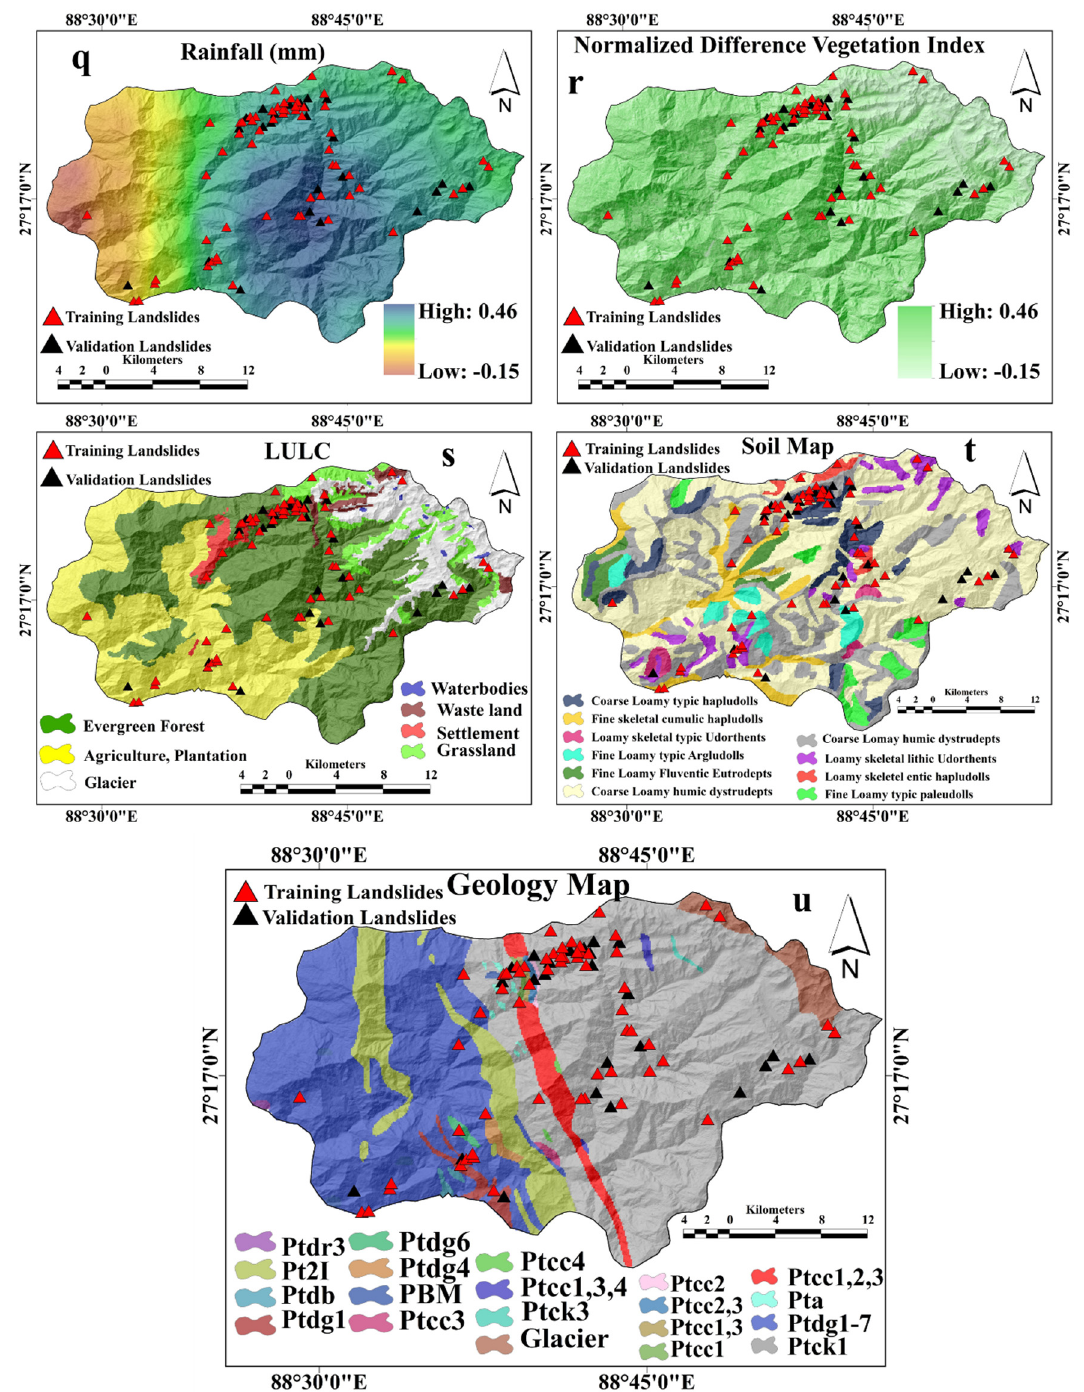
Figure 4. LCFs used in modelling landslide susceptibility: ( a ) elevation, ( b ) slope degree, ( c ) slope aspect, ( d ) plan curvature, ( e ) profile curvature, ( f ) convergence index, ( g ) topographic position index, ( h ) terrain ruggedness index, ( i ) topographic wetness index, ( j ) surface area, ( k ) general curvature, ( l ) tangential curvature, ( m ) cross sectional curvature ( n ) longitudinal curvature, ( o ) valley depth, ( p ) relative slope position, ( q ) rainfall, ( r ) NDVI, ( s ) LULC, ( t ) soil map and ( u ) geology map.